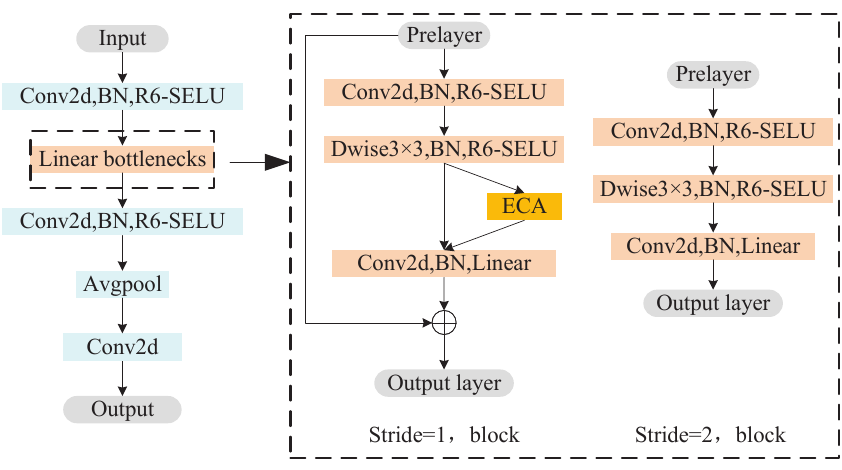
Figure 7. The overall framework of the